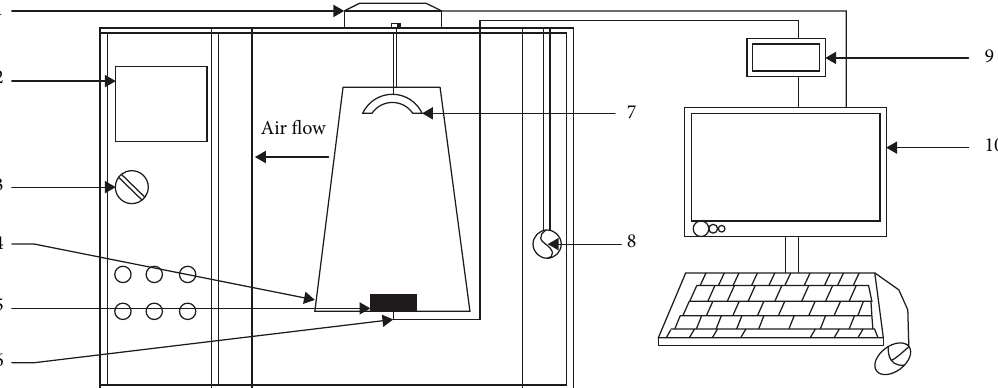
Figure 1: Schematic of the drying cabinet. 1: Weighing balance; 2: digital control panel; 3: power knob; 4: drying platform; 5: beef sample; 6: K-type thermocouple; 7: infrared emitter; 8: anemometer; 9: temperature datalogger; 10: computer